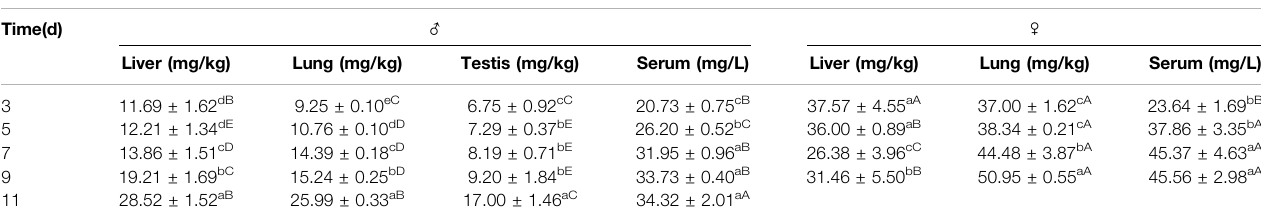
TABLE 1 | Concentrations of Na-DHA in serum and some tissues of